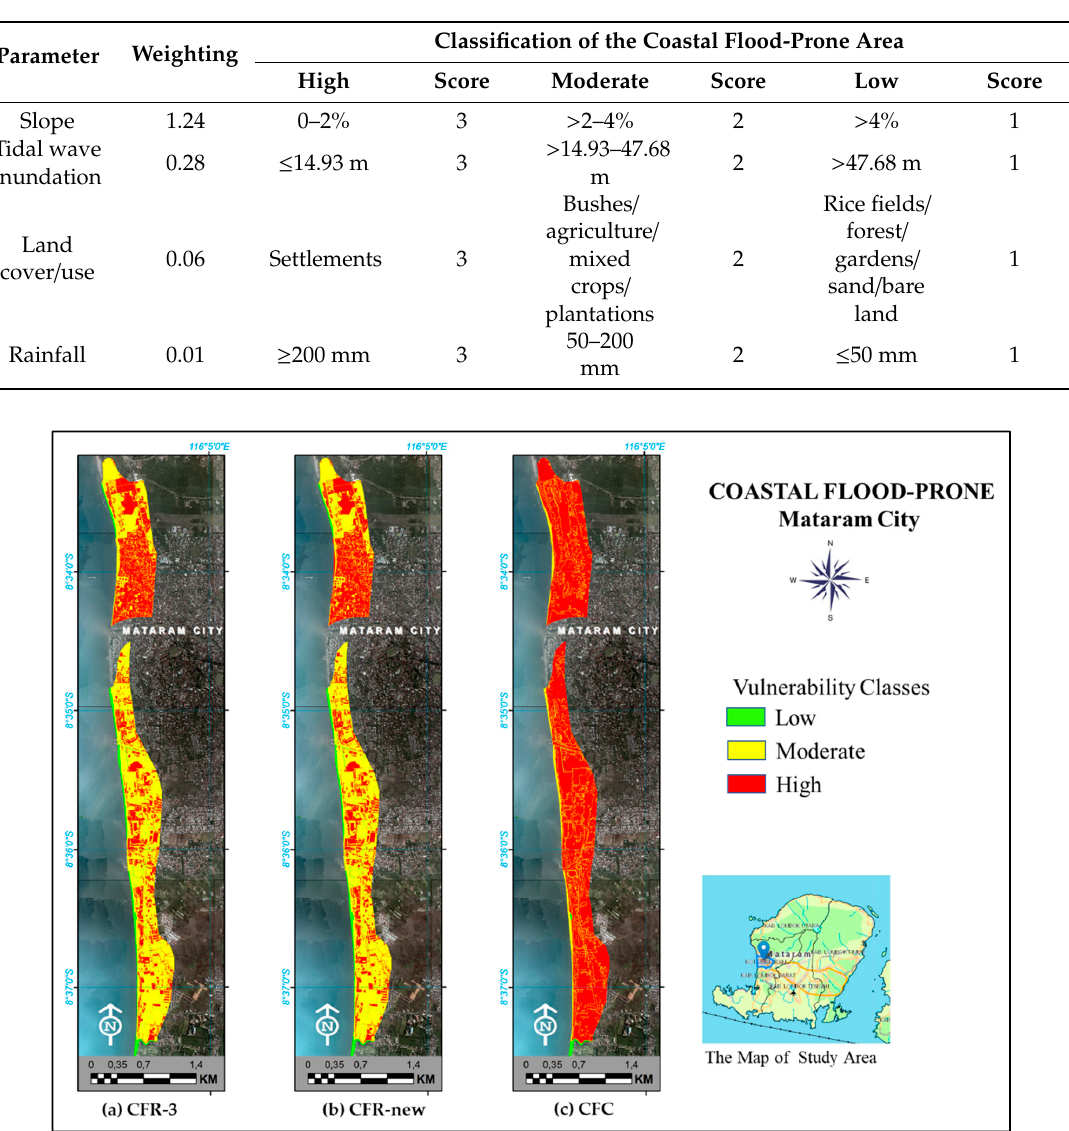
Table 7. Matrix of the MCE for the CFC method.